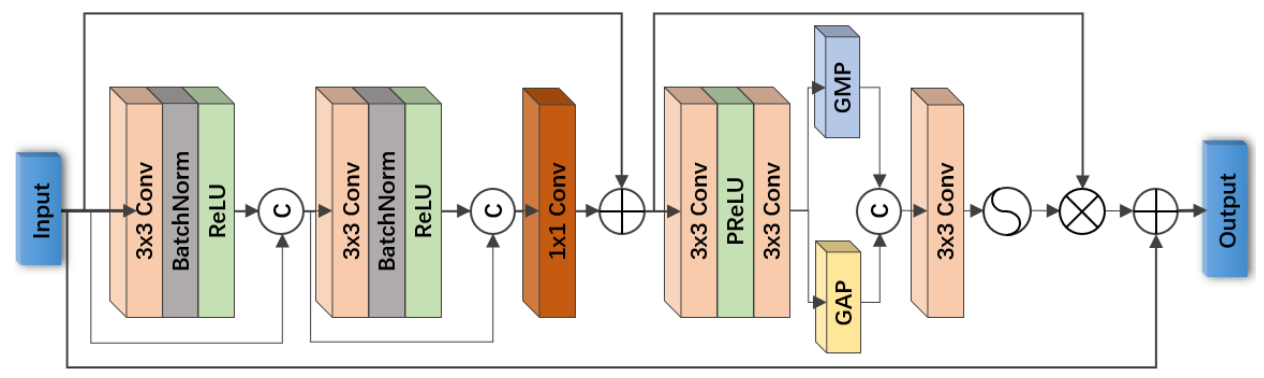
Figure 5. Double residual tandem spatial attention block